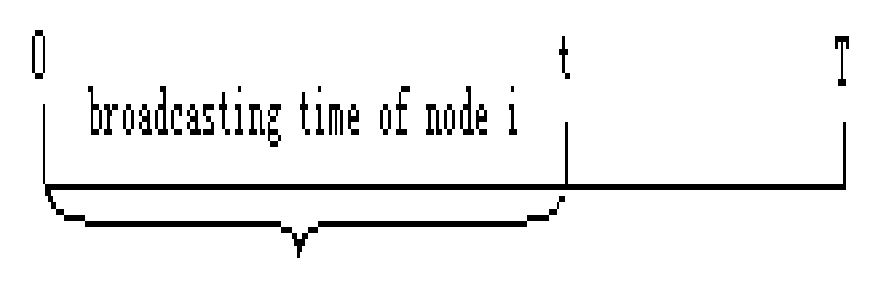
Figure 2. Illustration of broadcasting